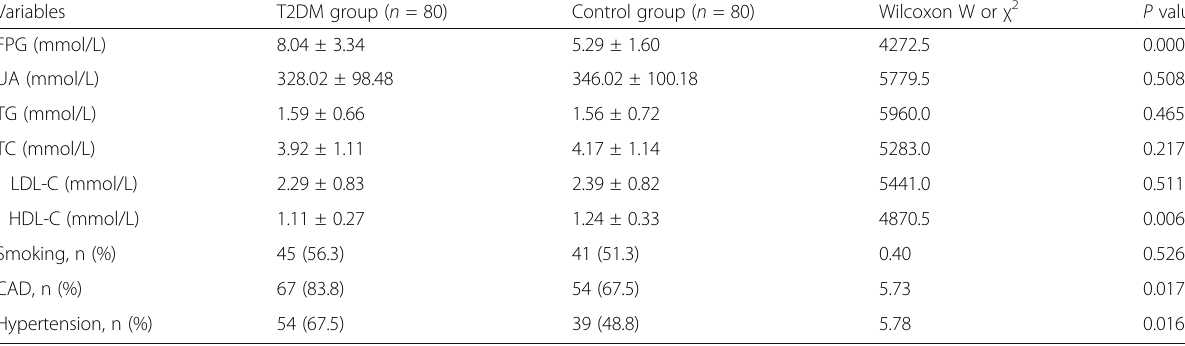
Table 1 Clinical characteristics of the study patients according to T2DM Variables T2DM group ( n = 80) Control group ( n = 80) Wilcoxon W or χ